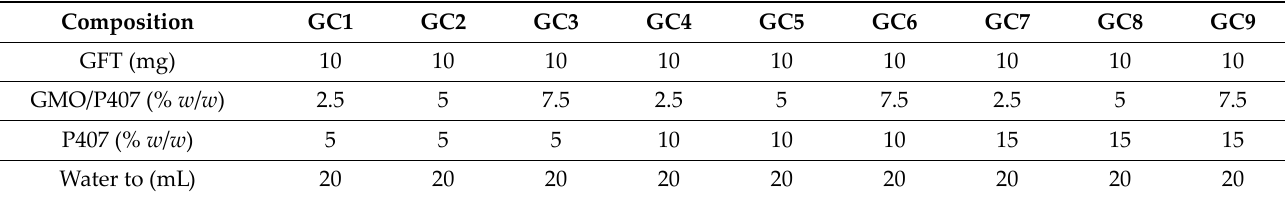
Table 1. Composition of different